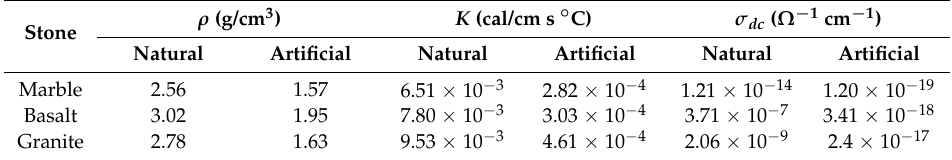
Table 3. The density, ρ , thermal conductivity, K , and electrical conductivity, σ dc , for optimized artificial stone sheets based on PMMA/SSF/clayHNTs nanocomposites compared to natural stones.